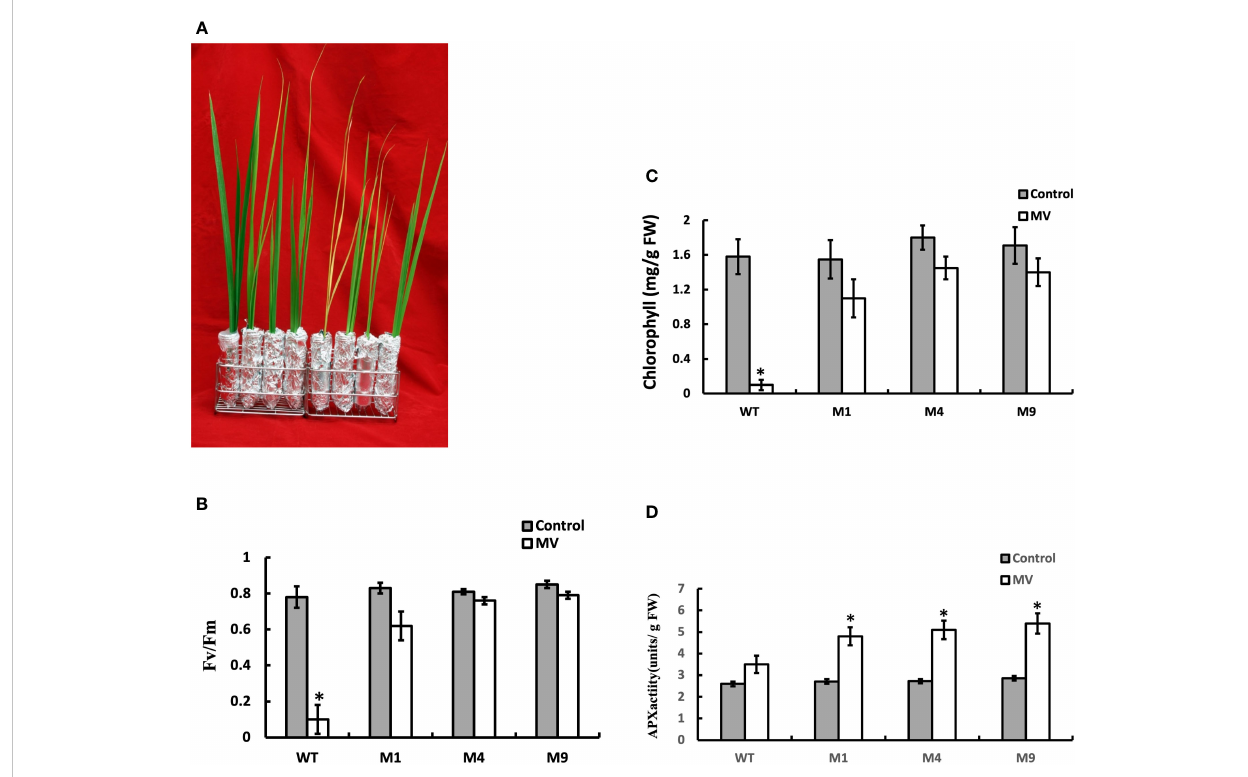
FIGURE 8 Transgenic AtMSRB5 rice is tolerant to MV-induced oxidative stress. Sixty-day-old seedlings were subjected to 20 m M MV treatment for 7 days. (A) Their survival phenotype was examined. (B) F v/ F m ratio, (C) Chlorophyll content, and (D) Ascorbate peroxidase (APX) activity were determined. Data are means ± SD ( n = 3) of 3 independent experiments and were analyzed statistically using student ’ s t test. *, P <